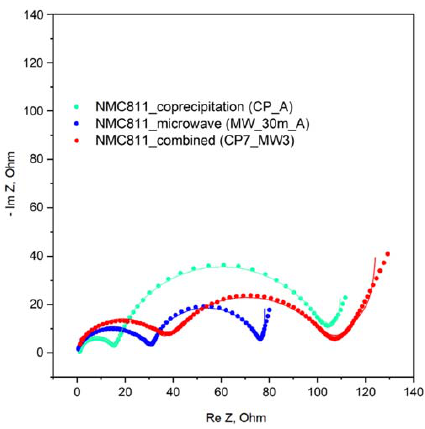
Figure 14. Nyquist plots and equivalent circuit fit (see Table S2 of Supplementary Materials for the fit parameters) for the NMC811 samples prepared via microwave-assisted hydrothermal and co- precipitation techniques, and the mix of these two